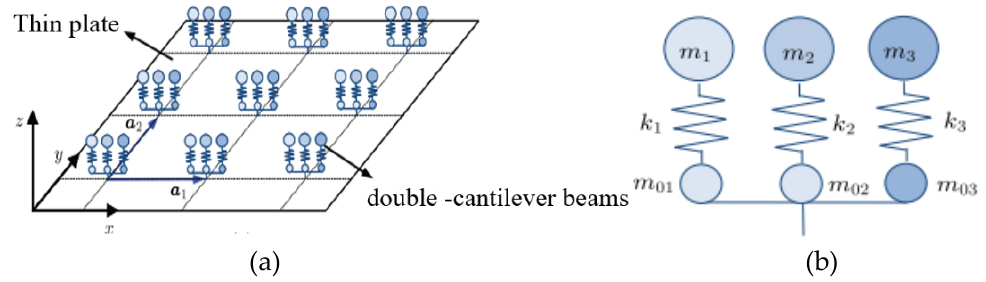
Figure 5. Schematic diagram of a multi-frequency locally resonant phononic plate: ( a ) Schematic diagram of the phononic plate with several periodic unit cells;( b ) schematic diagram of the attached double -cantilever beams [36].